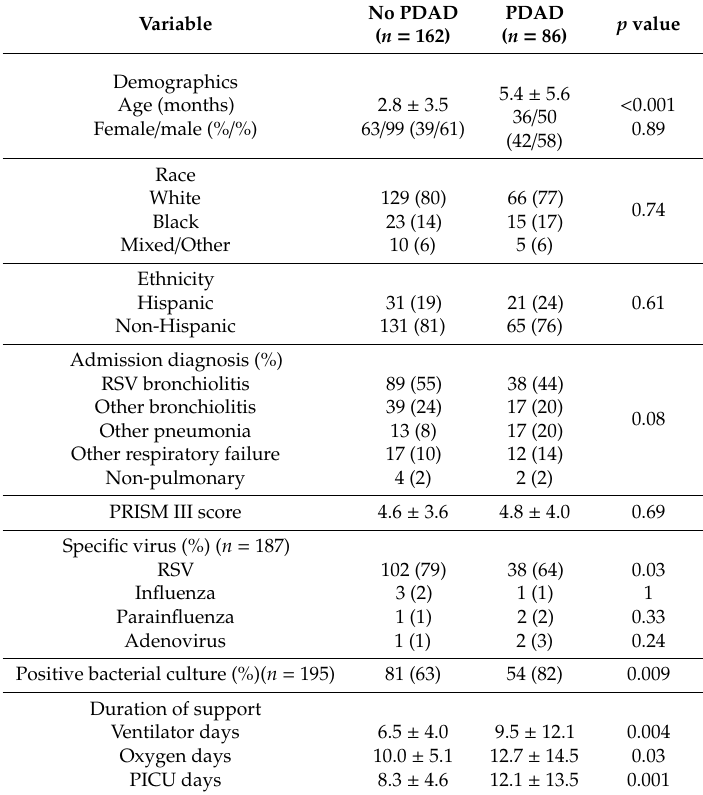
Figure 1. Study outline. Previously healthy children with acute respiratory failure (ARF) are enrolled in the study ( n = 250). Two children subsequently diagnosed with cystic fibrosis were excluded from final analysis ( n = 248). The statistical analysis (shown by a blue double headed arrow) is done between the cases (ARF, n = 248) and controls (healthy newborns, n = 468). Then, further analysis was performed between the cohort of children with and without pulmonary dysfunction at discharge (PDAD) shown in red double headed arrow ( n = 86 vs 162). Table 1. Demographics of cohort stratified by pulmonary dysfunction at discharge